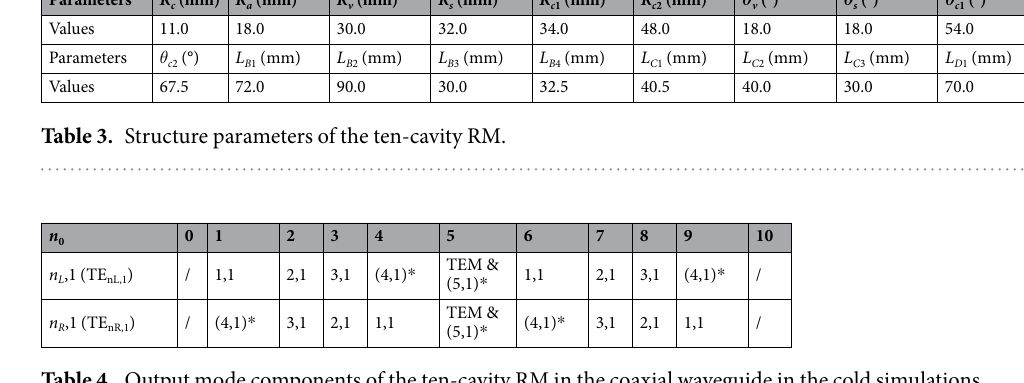
Table 4. Output mode components of the ten-cavity RM in the coaxial waveguide in the cold simulations * Indicates that the mode in the bracket is an evanescent higher order